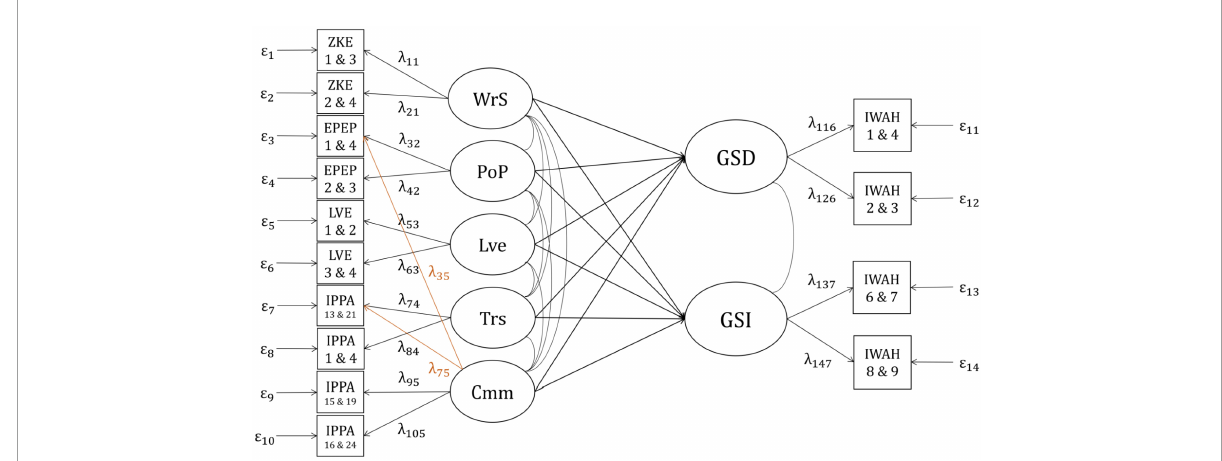
FIGURE4 Positive regression model for the German and the English sample. WrS, Warmth/Support; PoP, positive parenting; Trs, trust; Cmm, communication; GSD, global self-definition; GSI, global self-investment; ZKE, “Zürcher Kurzfragebogen zum Erziehungsverhalten”; EPEP, “Evaluation des Pratiques Educatives Parentales”; LVE, items measuring parental love; IPPA, “Inventory of Parent and Peer Attachment”; IWAH, “Identification With All Humanity scale.” Latent factors (e.g., WrS) are displayed in circles. Indicators (e.g., ZKE 1 and 3) are displayed in squares. Numbers beneath the abbreviations of questionnaires indicate item numbers of the items forming particular indicators (e.g., Item 1 and item 3 from the ZKE form one indicator displayed as ZKE 1 and 3). Arrows with factor loadings (e.g., λ 11 ) illustrate the assumption that the indicators are predicted by specific latent factors. Residual variances are displayed left and right to the indicators (e.g., ε 1 ). Curved lines indicate correlations between latent factors. Arrows from latent variables to other latent variables (e.g., WrS → GSD) illustrate the idea that one variable on which the arrow points (e.g., GSD) is predicted by another (e.g., WrS). The change from the original model in Figure 1 , which was modified slightly in the CFA, is marked in orange. In contrast to the correlation model which resulted from the CFA, in the present predictive model, the two facets of IWAH (GSD and GSI) are regressed on the variables representing pRPB and